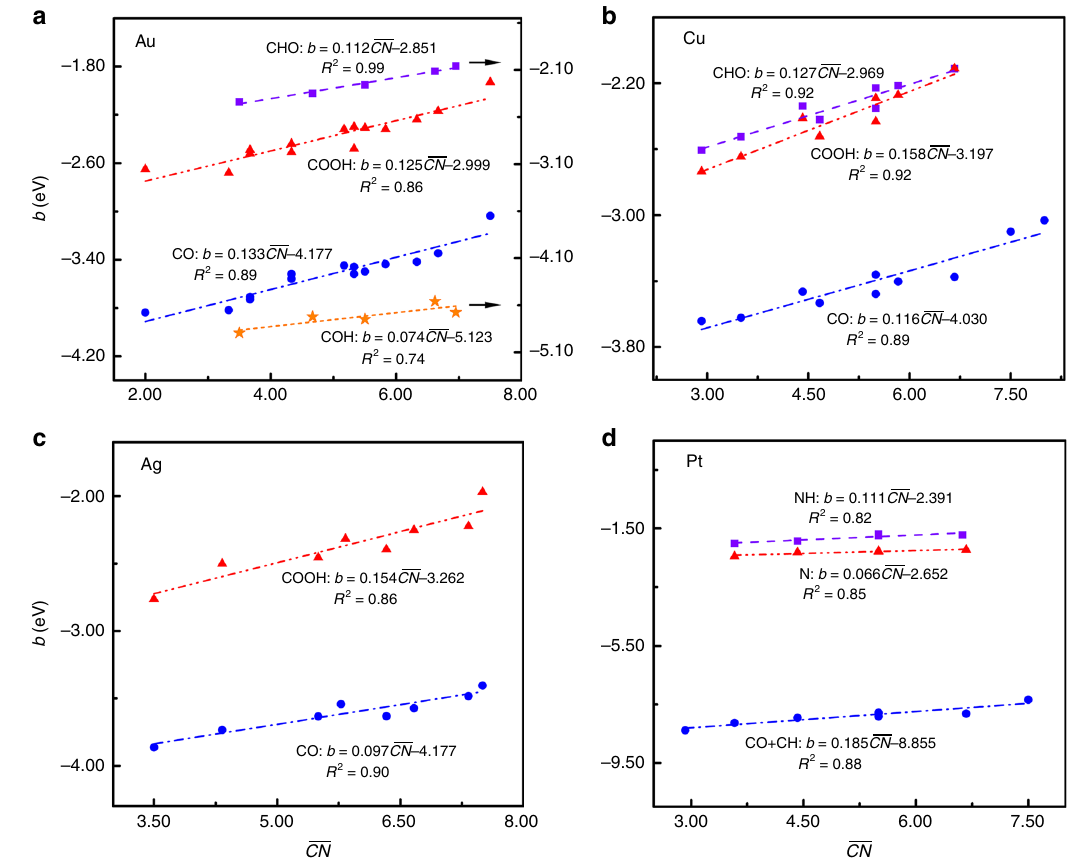
Fig. 2 Structure-offset b relations for species binding via C and N. a COOH (red triangles) and CO (blue circles) on fourteen different types of Au surface sites 26 , and CHO (purple cubes) and COH (orange star) on fi ve different types of Au surface sites 24 . b COOH (red triangles), CO (blue circles), and CHO (purple cubes) on ten different types of Cu surface sites 28 . c COOH (red triangles) and CO (blue circles) on eight different types of Ag surface sites 25 . d N (purple cubes), NH (red triangles), and CO + CH (blue circles) on seven different types of Pt surface sites 27 . In each panel, the offset b of the ψ -determined scaling relation is linearly correlated with the generalized coordination number CN of surfaces. The details of surface sites are provided in Supplementary Tables 1, 2, and 7, whereas the linear fi ts are provided as insets and the corresponding parameters are summarized in Supplementary Table 8. Clearly, the offset b is linearly scaled with the structure parameter following Eq. (4) in the main text. The prefactor λ of the term is also governed by electron-counting rules and can be described by the saturated-bond number of the central atom in adsorbates. Source data are provided as a Source Data fi